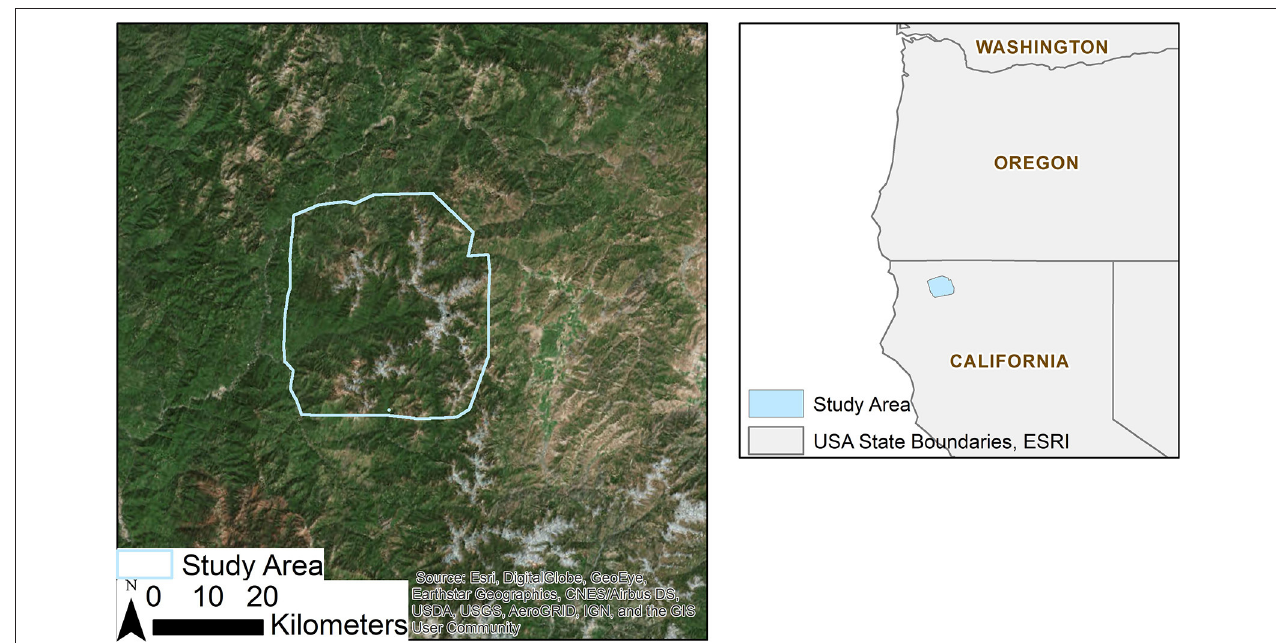
FIGURE 1 | Map of the study area, a 190,000-hectare area in northwest California, primarily centered on the Marble Mountain Wilderness.